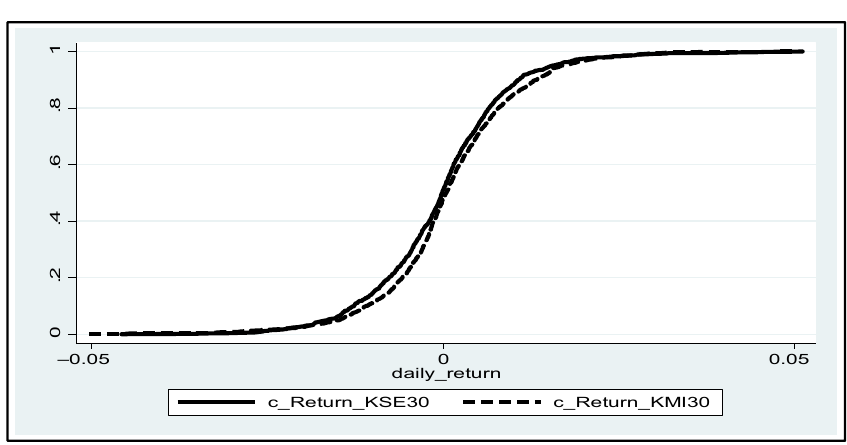
Figure 3. SD of KMI-30 returns over KSE-30